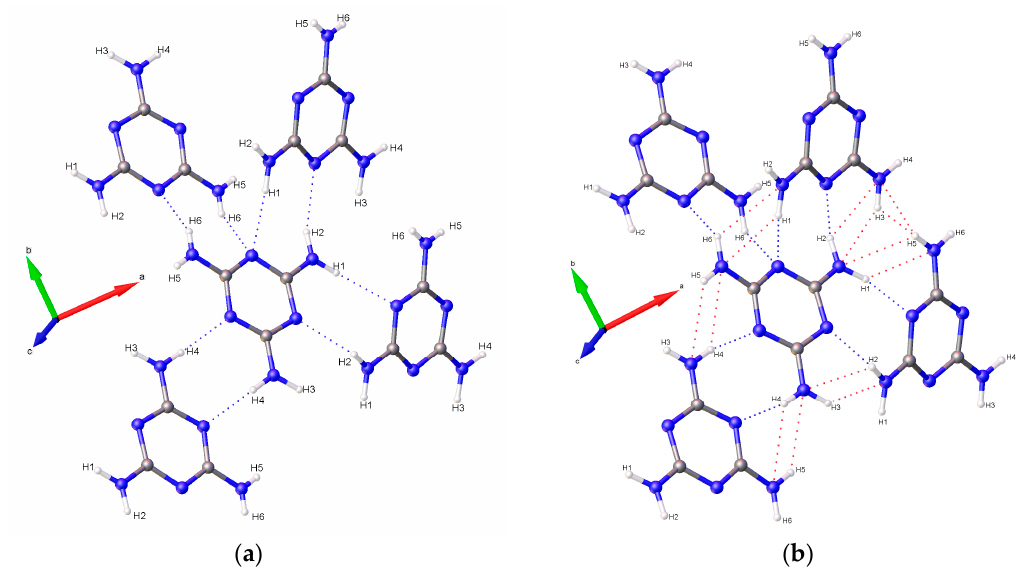
Figure 1. Hydrogen bonding network of melamine at ( a ) low (0.96(5) GPa) and ( b ) high (36.21(5) GPa) pressures. Potential hydrogen bonding interactions between anti-parallel amino N-H groups induced by pressure are displayed in red. Bonds behind and in front of the plane of view are omitted for clarity.